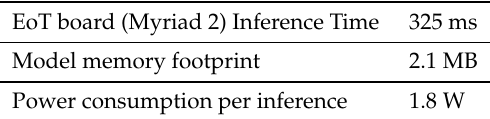
Table 5. Network characterization on EoT board (Myriad 2).